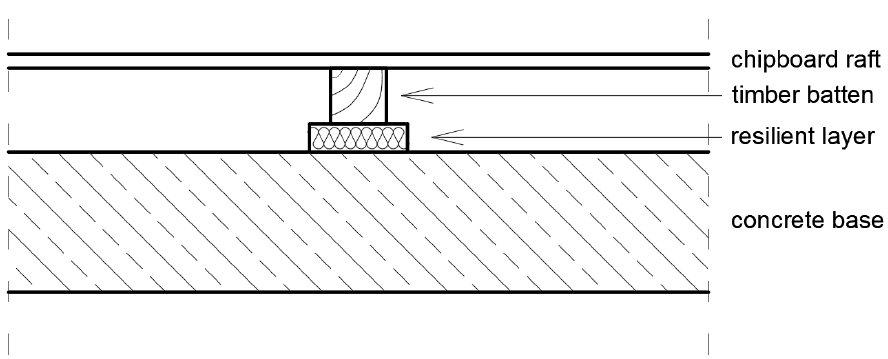
Figure 14. An example of asphalt floating floor or dry floating floor constructions with rebound polyurethane foam as a resilient layer (own elaboration).